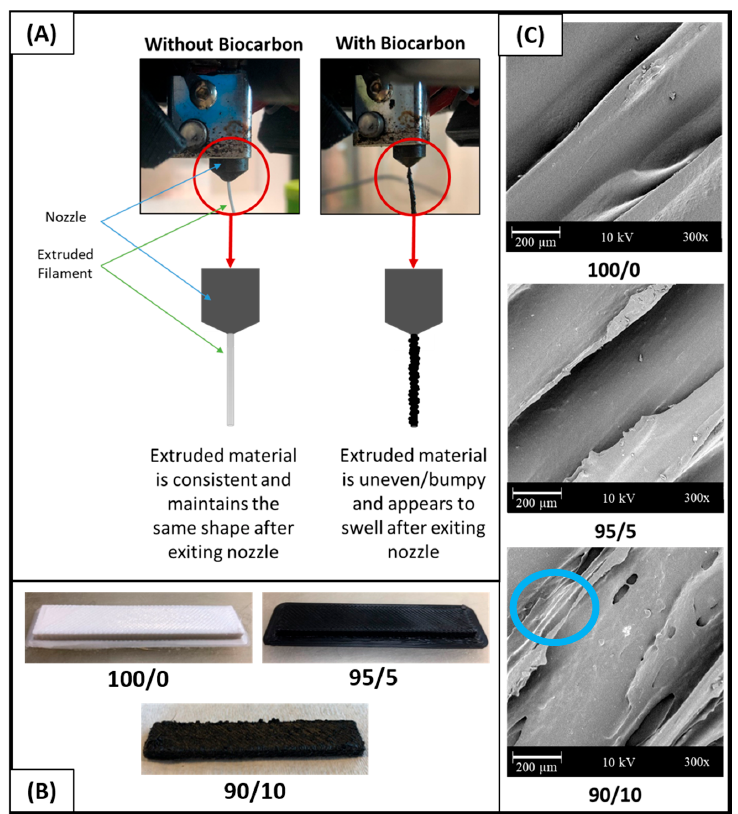
Figure 2. PTT/BC biocomposites in FFF: ( A ) the upper left section provides a comparison of an extrudate with and without biocarbon to depict challenges with consistency, ( B ) the lower left section compares FFF samples with different BC content for surface roughness, and ( C ) the right side of the image examines SEM images of the FFF surface of FFF printed samples. See Table 2 for nomenclature.